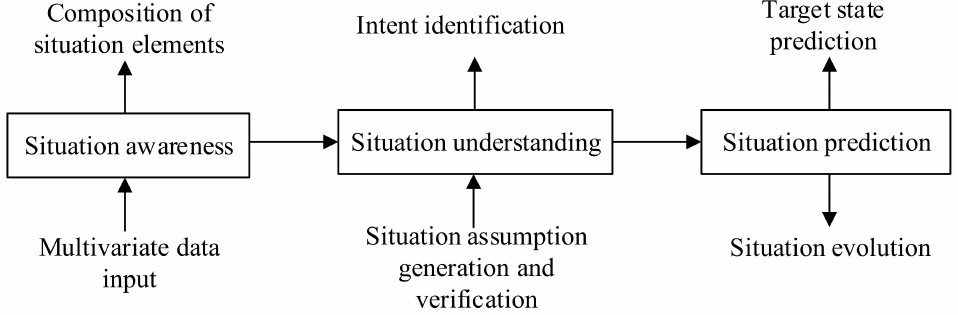
Figure 4. Functional model of situation assessment.